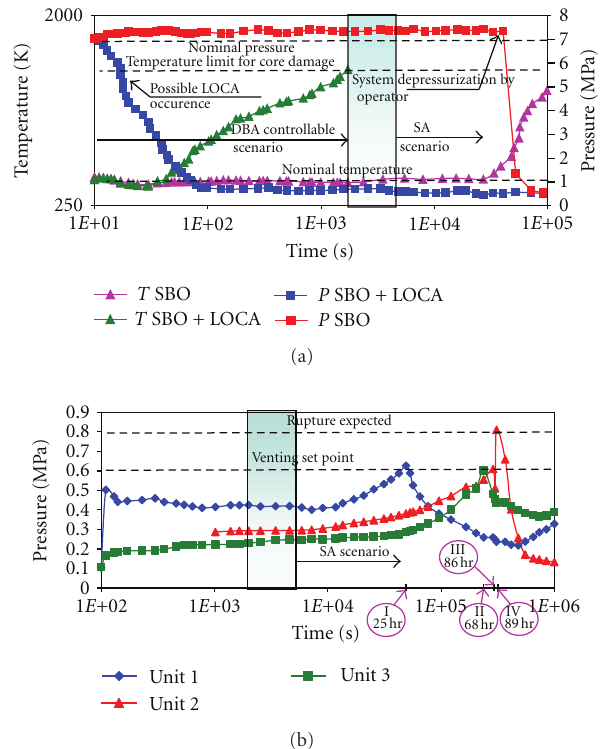
Figure 3: Possible, rough time evolutions of key variables during the Fukushima event in the time period between events: (a) 1 and 5 of Table 2(a), where means T: temperature, P: pressure; (b) 1 and 11 of Table